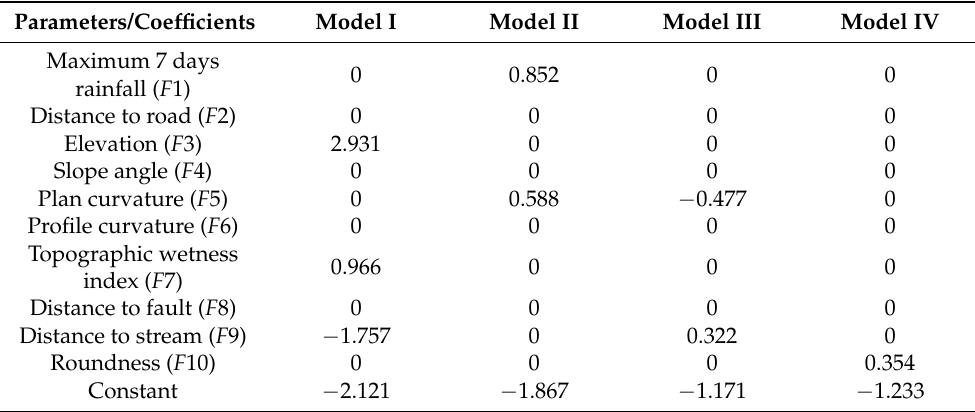
Table 5. Regression coefficients of each LR model.